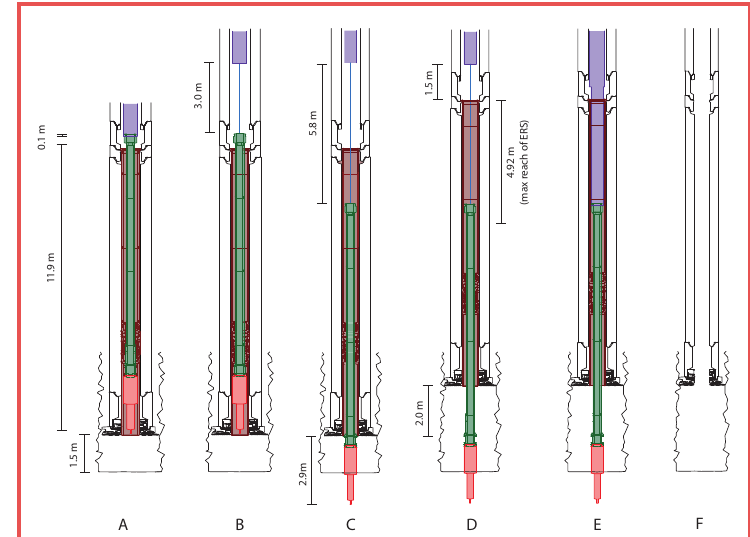
Figure 3. MDHDS deployment diagram. The MFTM and the ERS are purple, the Inner Barrel (IBS) is green, the OBS is brown, and the penetrometer is pink (See Fig. 1). [A] The MDHDS (IBS, OBS, and the attached penetrometer) is delivered to the BHA by the MFTM/ERS (purple). [B] Once the tool reaches the BHA,